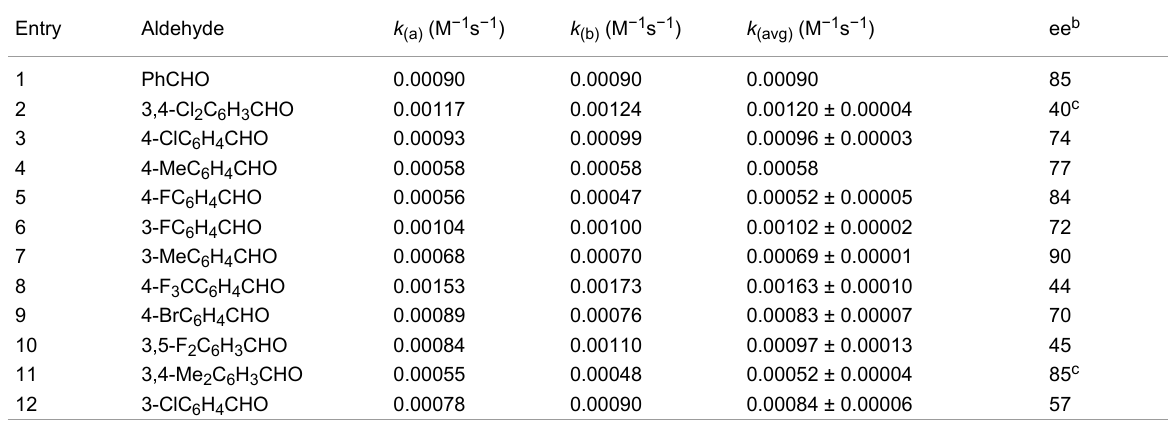
Table 5: Rate constants used to construct the Hammett plot. a